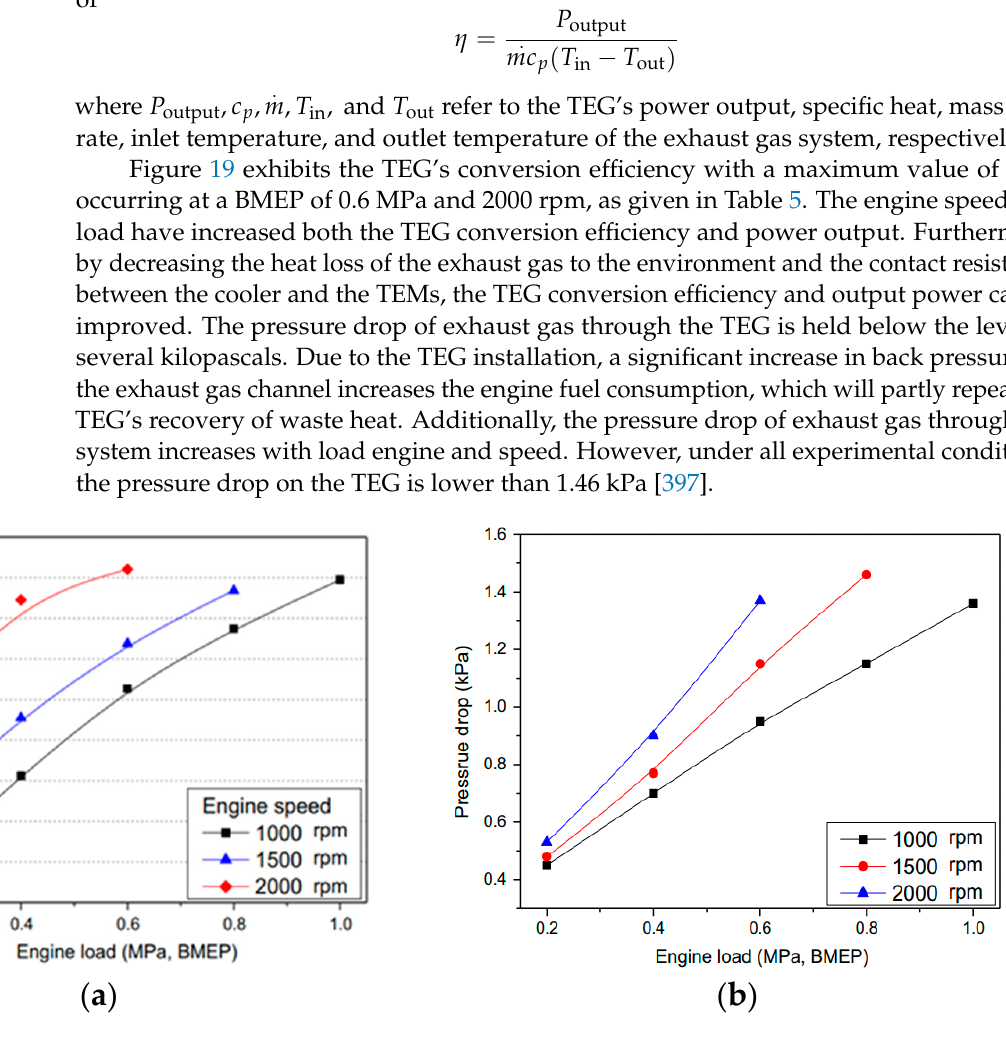
Figure 19. ( a ) Conversion efficiency and ( b ) pressure drop across the TEG at different engine loads and engine speeds [397].